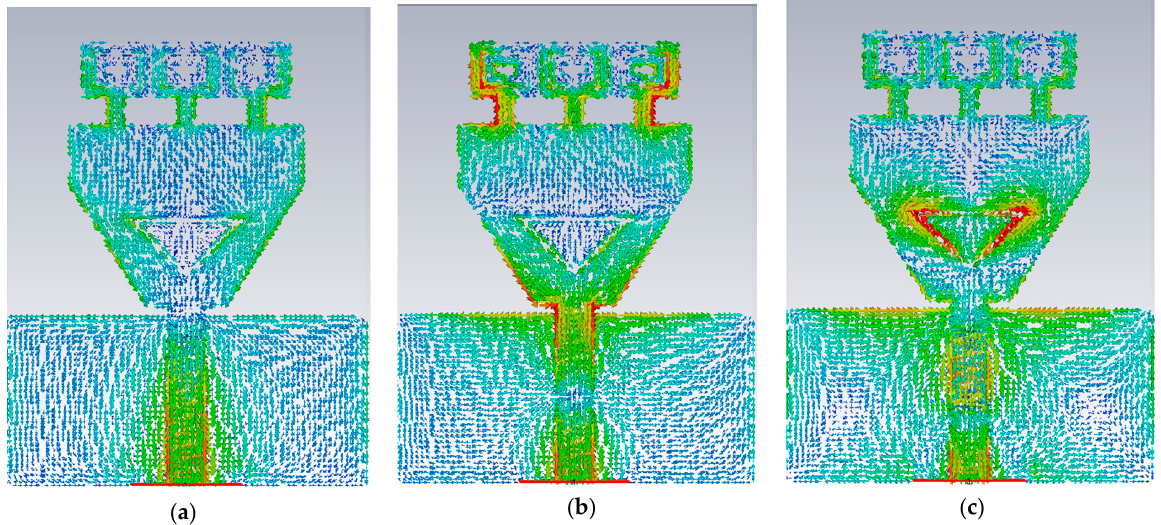
Figure 7. Surface current distributions of the proposed triple-band UWB antenna ( a ) 3.5 GHz ( b ) 6.1 GHz ( c ) 9.25 GHz.